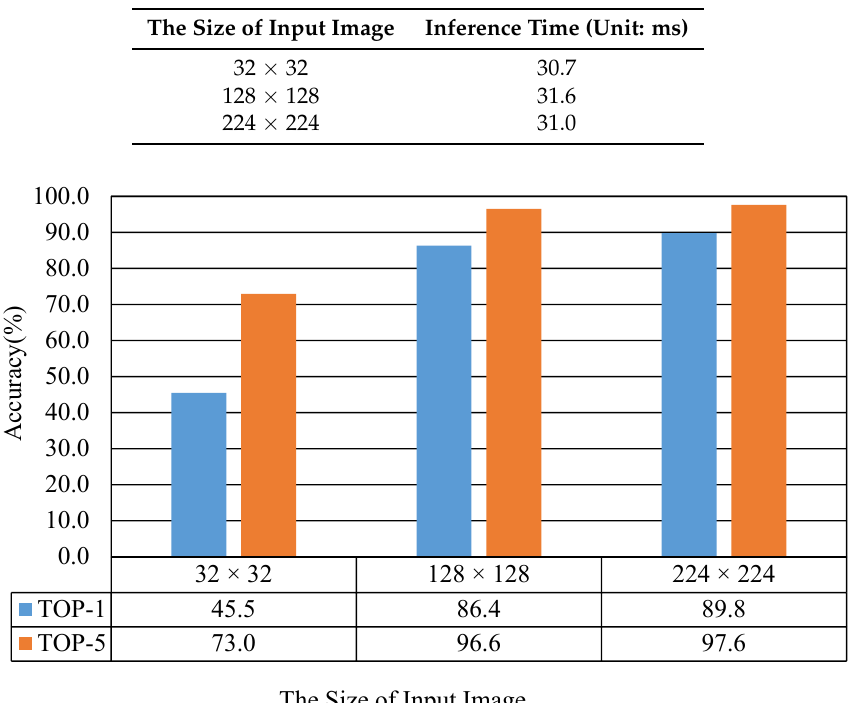
Figure 8. Recognition performance results according to the size of the input